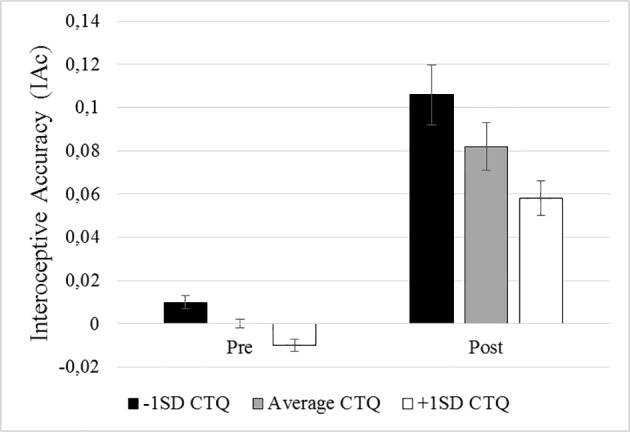
Illustration of the interaction between time and trauma. The black column represents participants scoring 1 standard deviation above the mean scores of the childhood trauma questionnaire (CTQ), the gray column represents participants with mean CTQ scores, and the white column represents participants scoring 1 standard deviation below the mean of the CTQ. Time (pre = baseline; post = after the stressor) is illustrated on the x-axis, IAc on the y-axis.